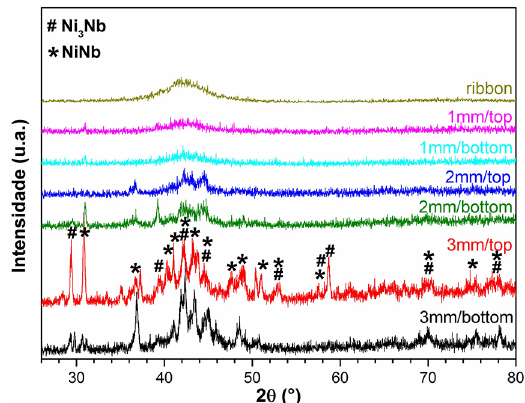
Figure 1. XRD results of the bottom and top parts of each rod (1, 2 and 3 mm diameters) and of ribbon.